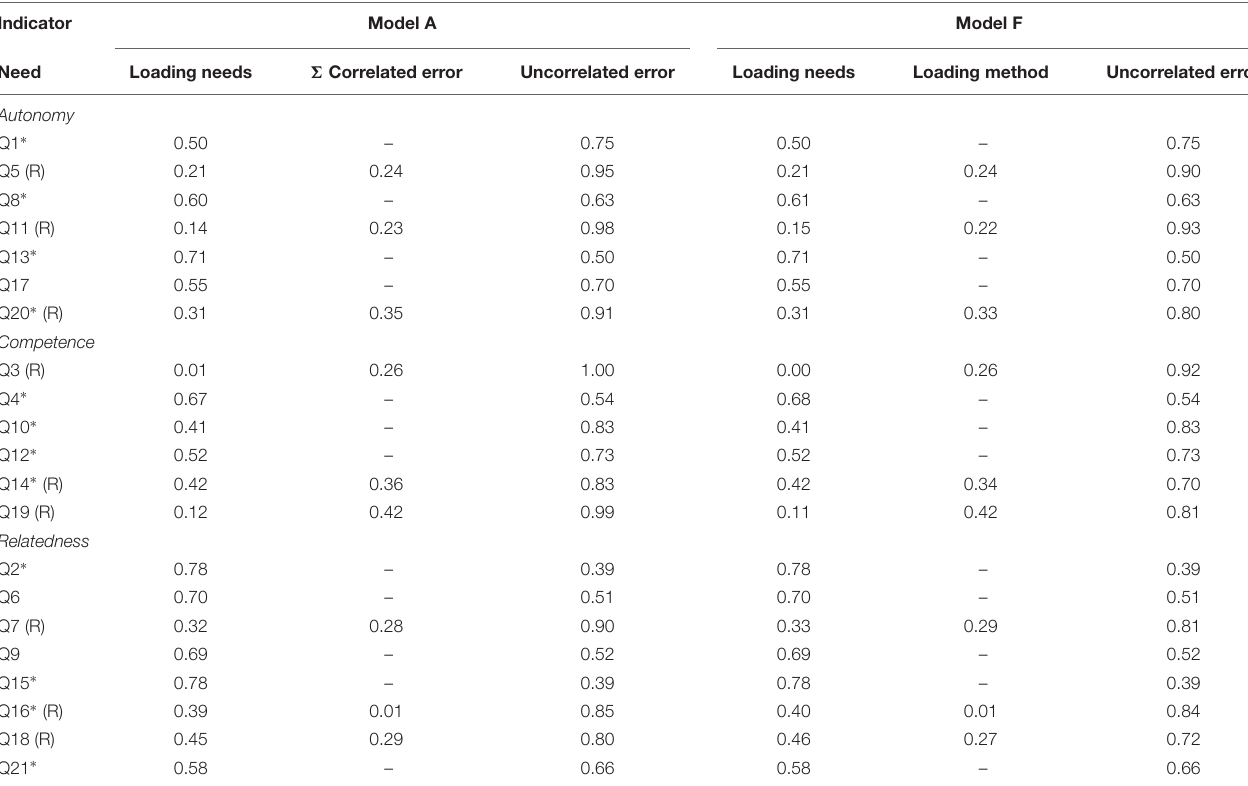
TABLE 3 | Error variance and factor loadings for Model A and Model F (standardized values, CS, N = 600). Indicator Model